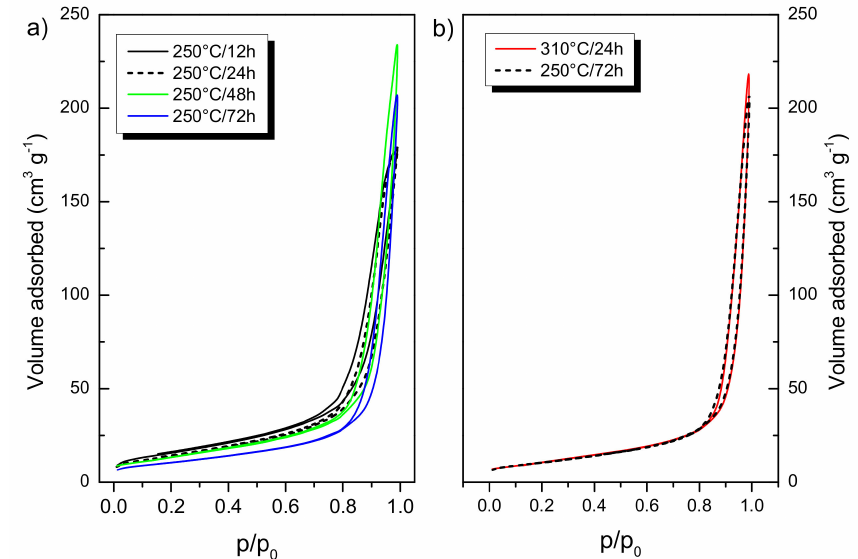
Figure 2. ( a ) N 2 -sorption isotherms of TiO 2 NPs treated hydrothermally at 250 ◦ C for 12 h, 24 h, 48 h, and 72 h; ( b ) shows the isotherms after hydrothermal treatment of TiO 2 NPs at 250 ◦ C for 72 h and 310 ◦ C for 24